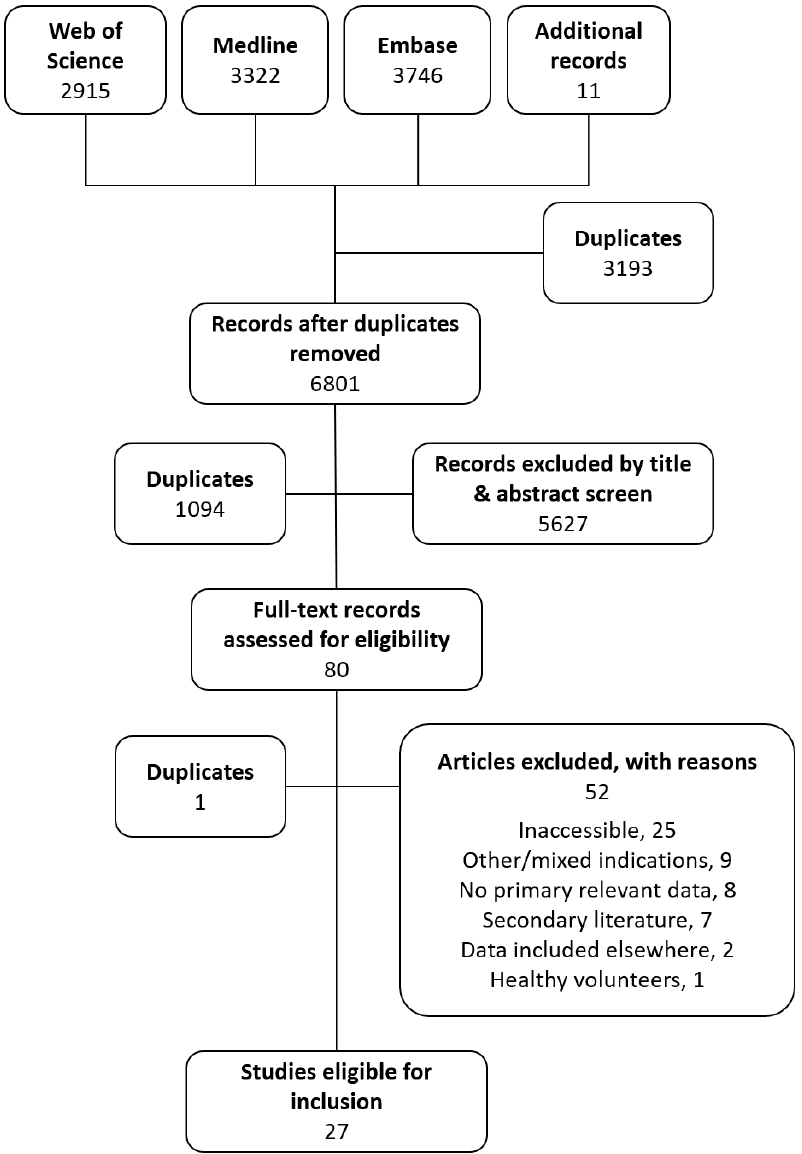
Figure 1. Flow diagram of study selection.